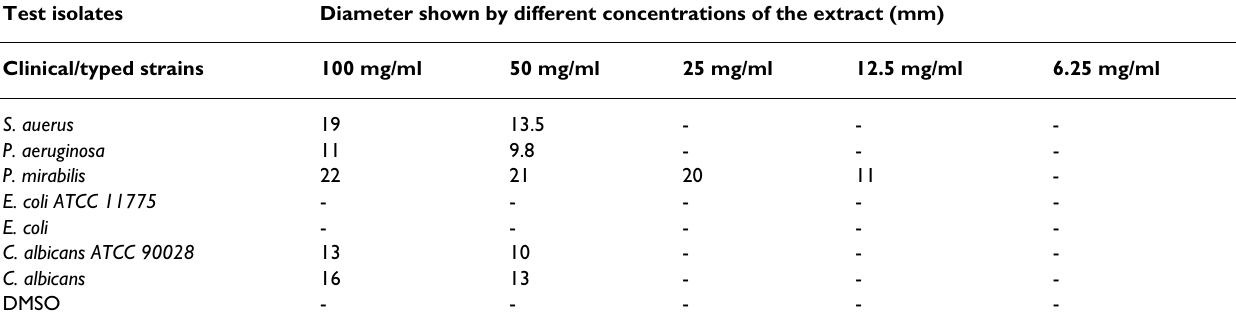
Table 2: The inhibition zone diameters shown by the test isolates against different concentrations of the plant extract Test isolates